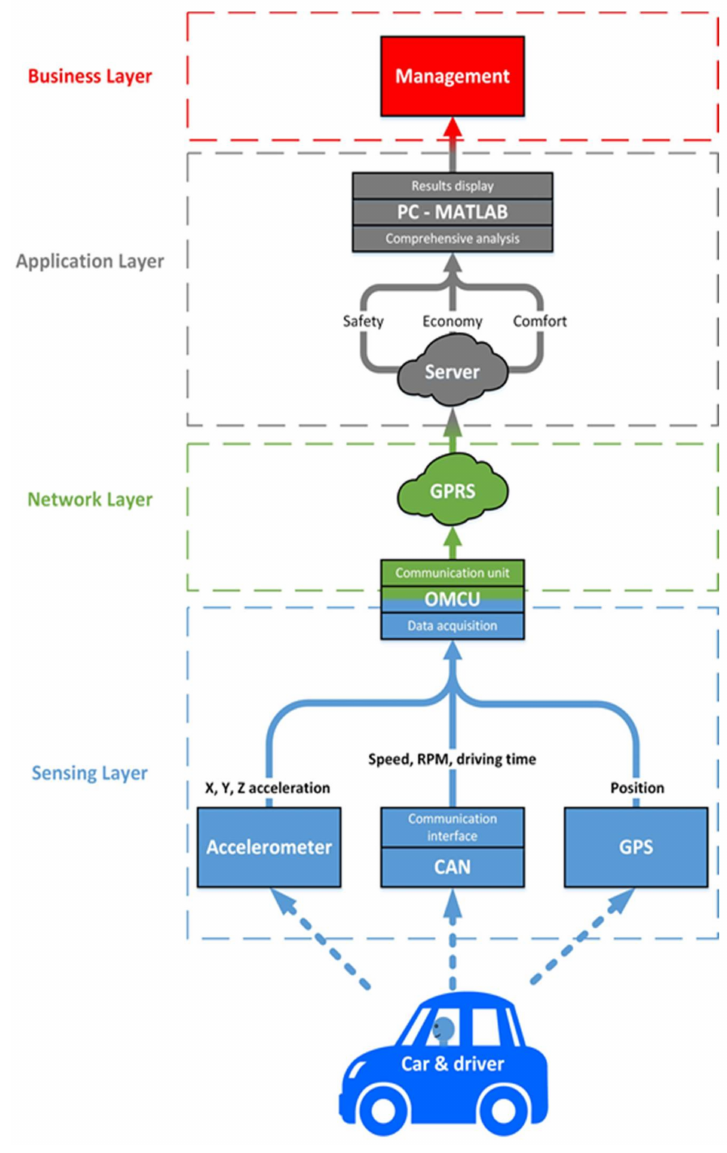
Figure 2. Architecture of the IoT-based driving style assessment